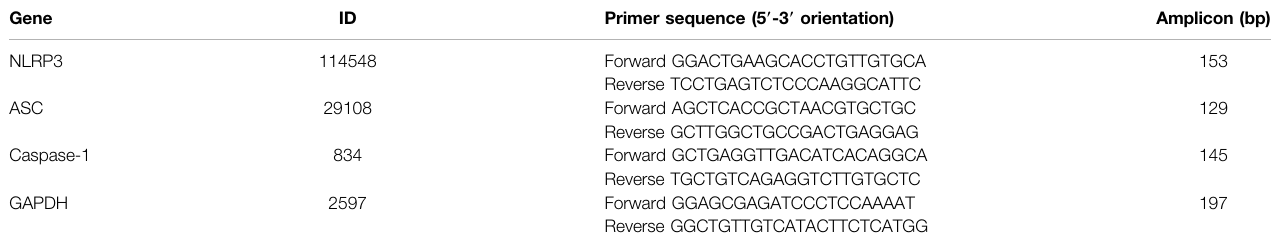
TABLE 2 | The sequences of primers for RT-PCR.